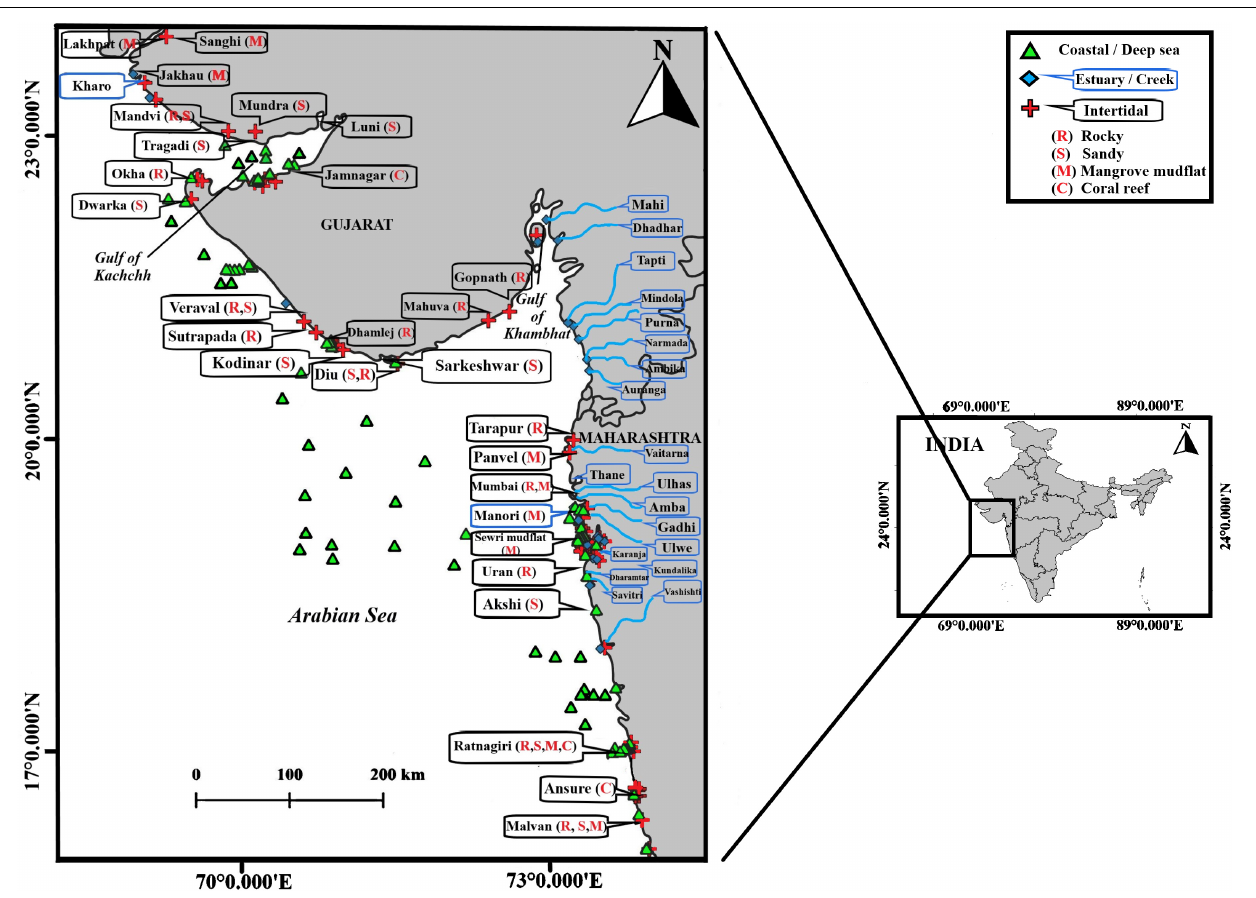
FIGURE 1 | Map of the study locations of macrobenthic investigations along North West coast of